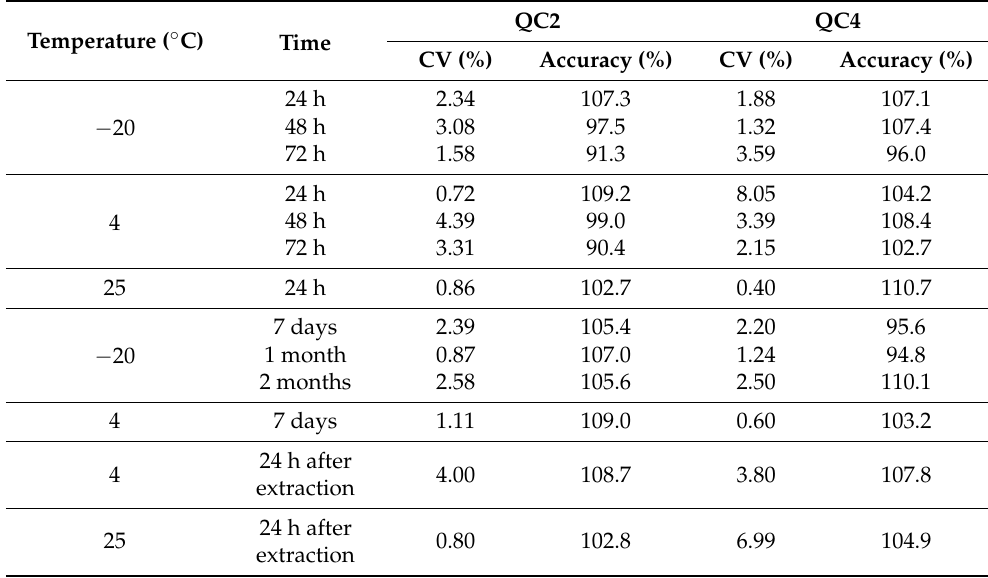
Table 6. Stability of QC2 and QC4 at different storage